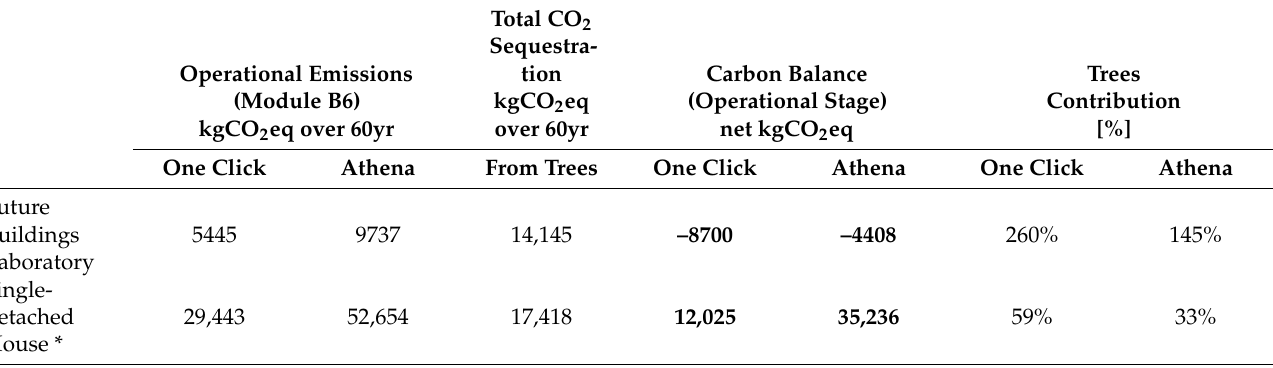
Table 11. Carbon balance considering only operational use